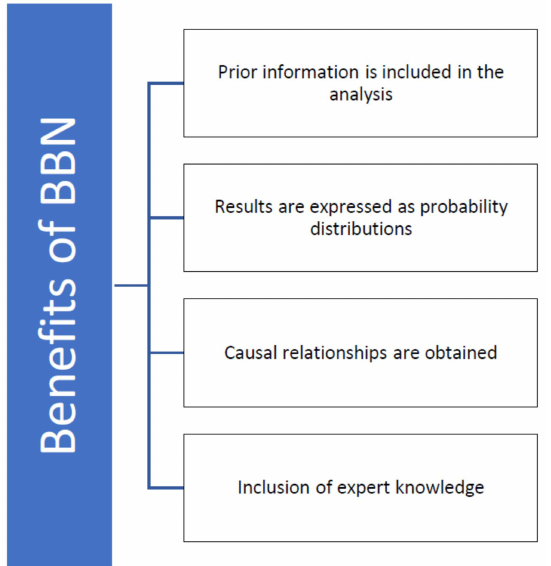
Figure 2. Major advantages of BBN for pavement assessment